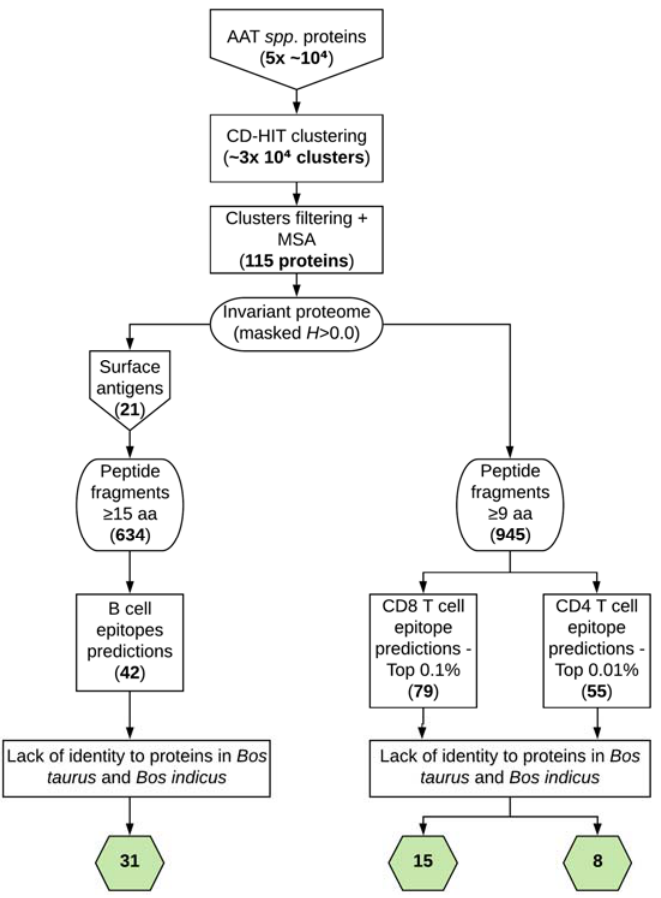
Figure 1. Flowchart summary of the epitope identification strategy. Larger boxes show the steps and